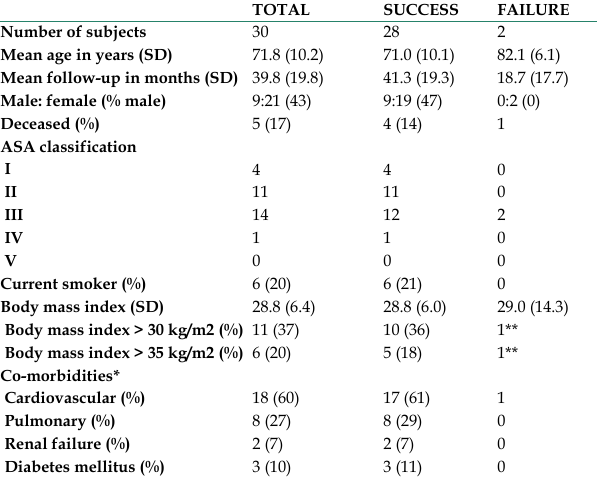
Table 1: Subject characteristics.